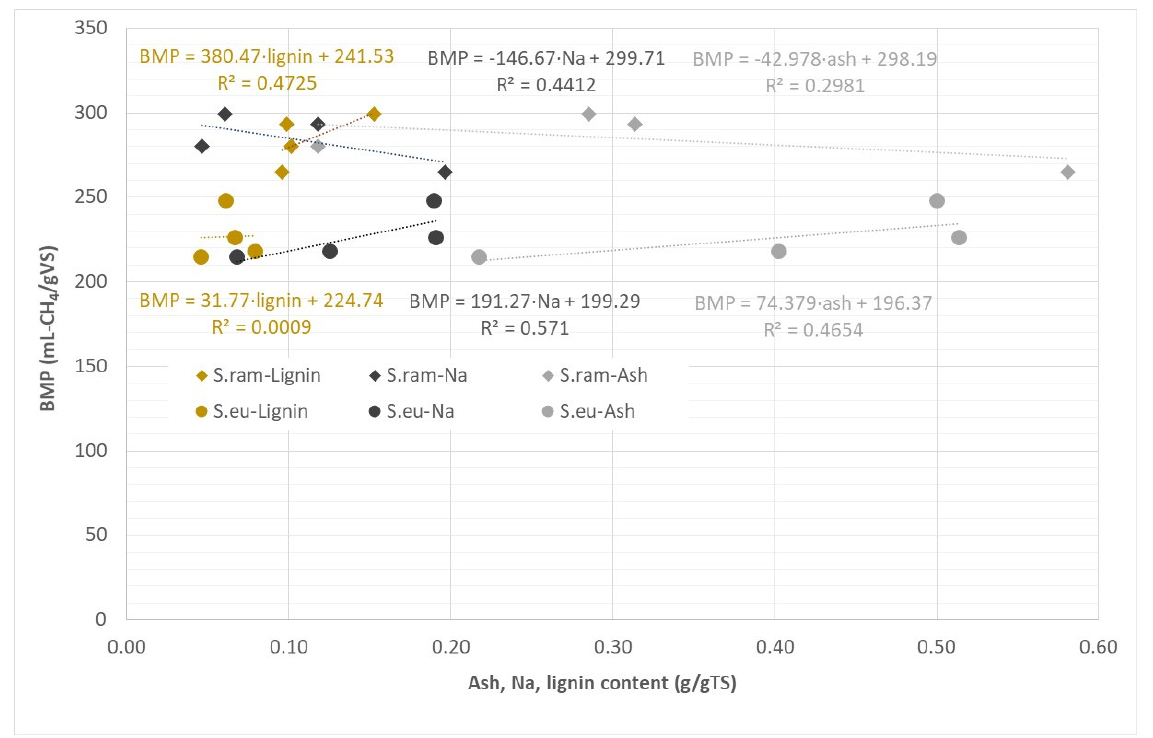
Figure 5. Correlations of ash, Na and lignin content and experimental BMP of the different samples of S . europaea (S.eu) and S. ramosissima (S.ram), including equations and R 2 factors of linear regres-